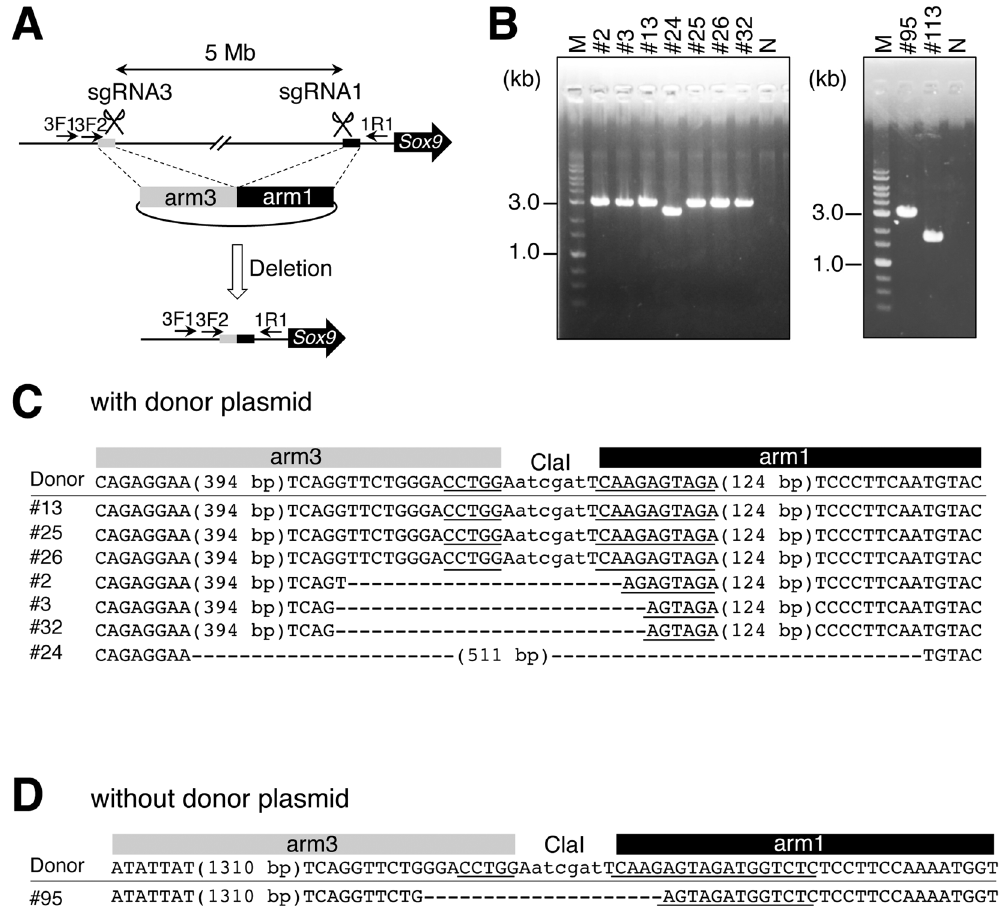
Figure 2. Generation of mutant mice with a 5-Mb deletion with or without a donor plasmid. ( A ) Schematic representation of the 5-Mb region upstream of Sox9 . The black line represents a genome sequence. Homology arms in a donor plasmid are indicated with black and gray boxes. PCR primers are indicated with arrows. Positions of sgRNA recognition sequences are denoted with scissors. ( B ) An agarose gel electrophoretogram image of PCR products amplified using 3F1 and 1R1 primers and DNA prepared from embryos injected with the donor plasmid (left panel) and without the donor plasmid (right panel). Embryo IDs are shown above images with the # sign. M: a 1-kb DNA ladder (markers); N: no template control. ( C ) Sequences of the donor plasmid and of embryos injected with the donor plasmid are aligned. Positions corresponding to arms and ClaI recognition sequence are indicated at the top. ( D ) Sequences of the donor plasmid and of embryos injected without the donor plasmid are aligned. Positions corresponding to arms and ClaI recognition sequence are indicated at the top. Parts of gRNA recognition sequences are underlined. Black and gray boxes correspond to those in ( A